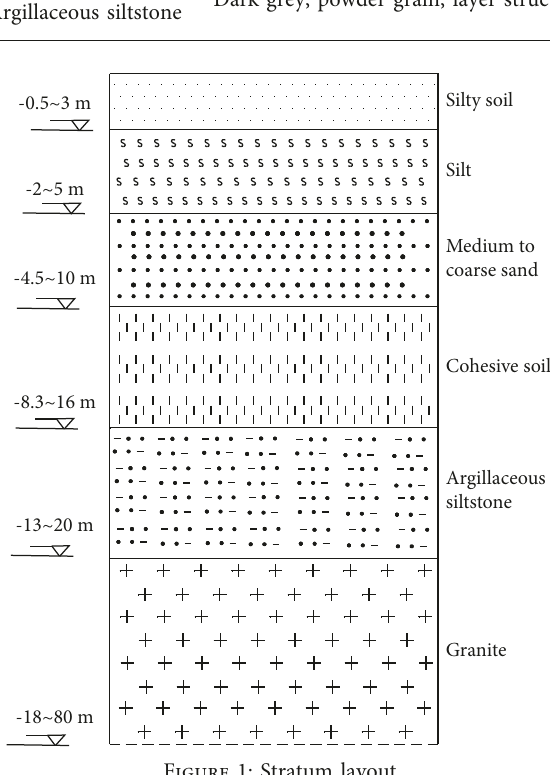
and high toughness. clay. medium dry strength, medium toughness. columns.